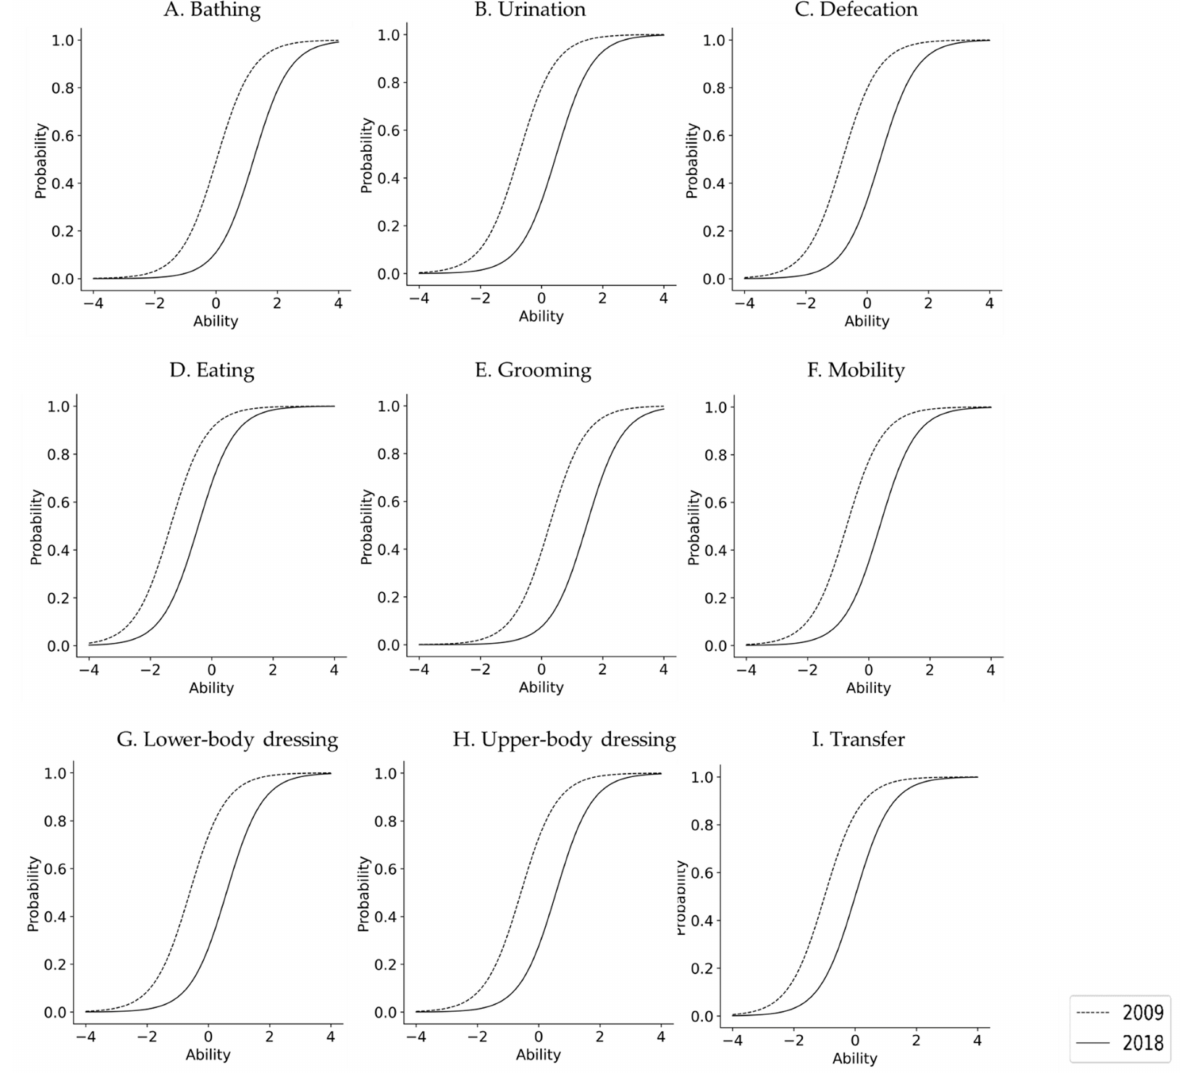
Figure 1. Difficulties in their ADL independence for all participants from 2009 to